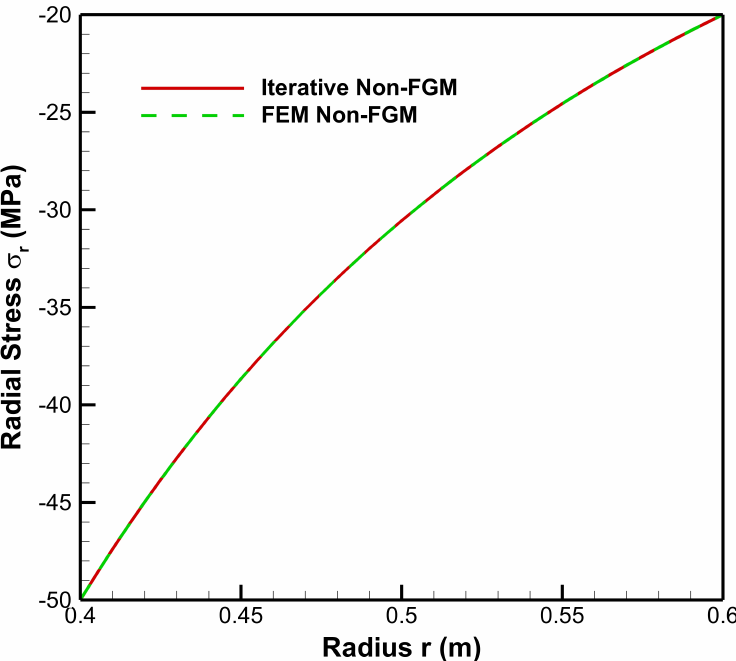
Figure 16. Comparison of radial stress along the radius of the cylinder under internal pressure, P a = 50 MPa and external pressure, P b = 20